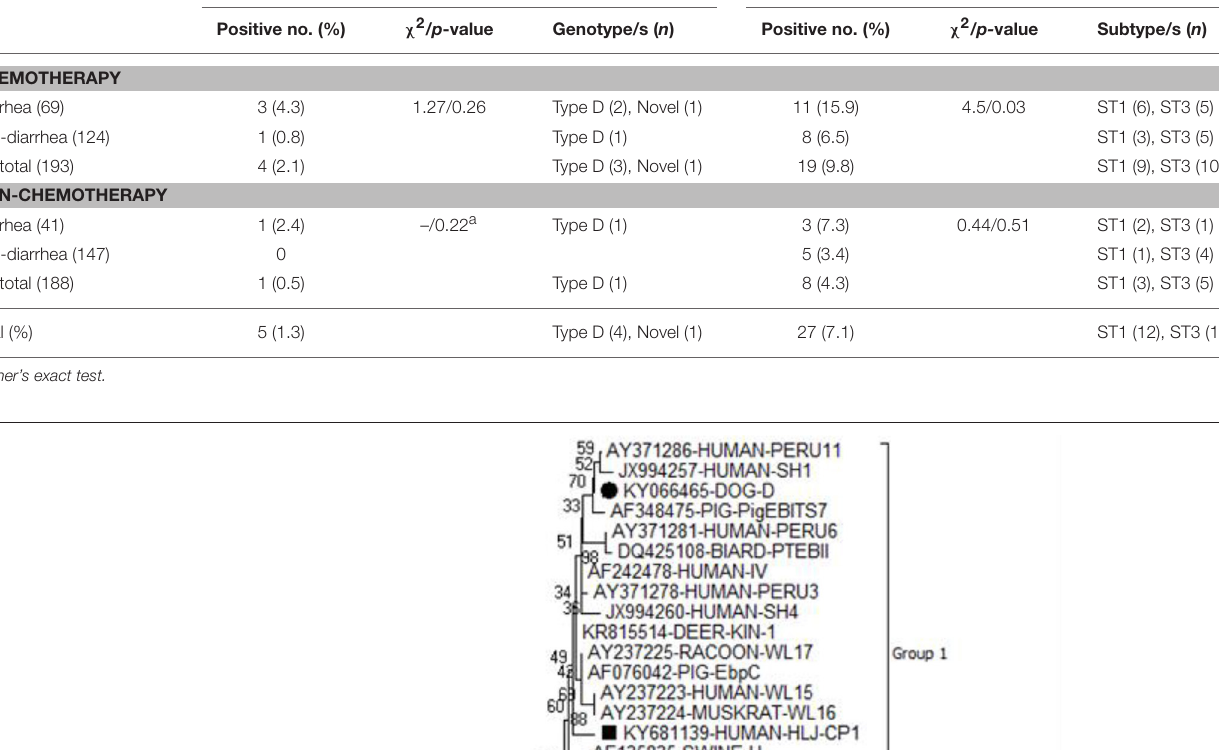
TABLE 2 | Prevalence and distribution of E. bieneusi genotypes and Blastocystis subtypes in cancer patients by treatment. Groups (Examined no.)